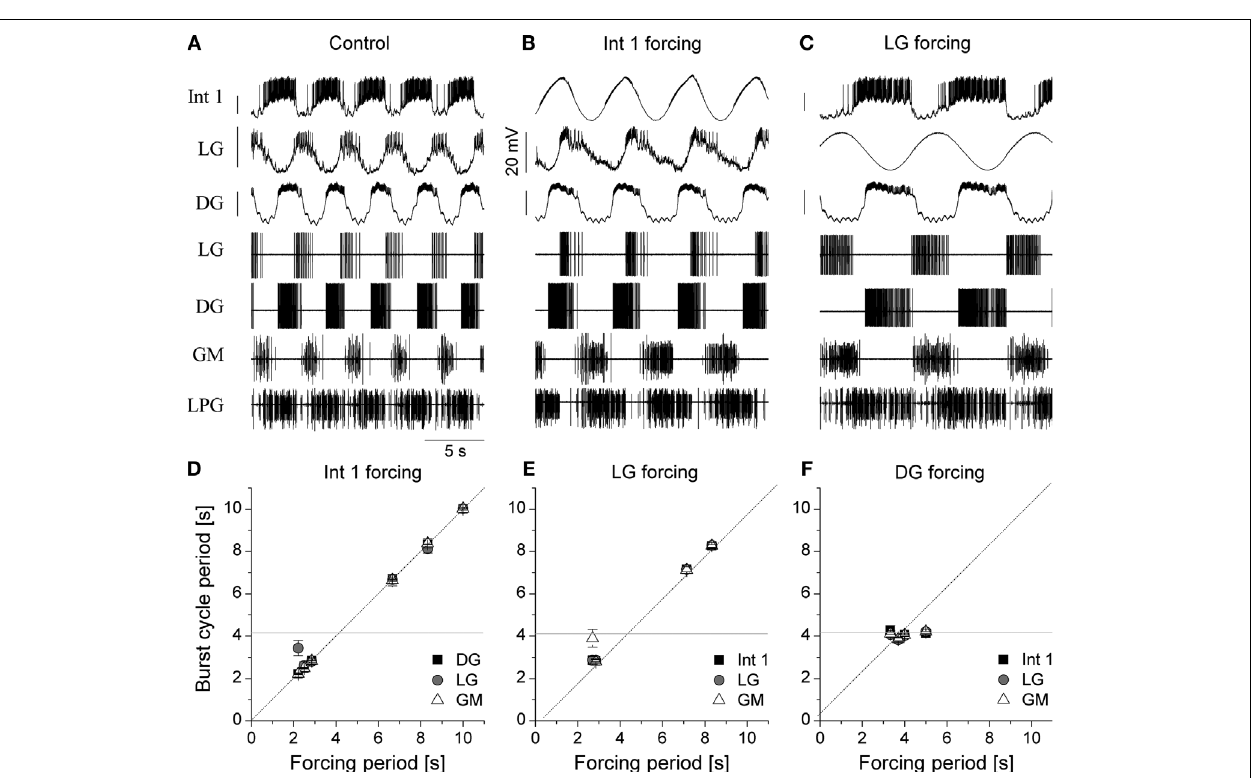
FIGURE 11 | Sinusoidal forcing of gastric neurons reveals a wide dynamical range of the network and shows the relative importance of circuit elements. The neurons were stimulated with a constant amplitude (3 nA) but variable frequency sinusoidal current and the synchronization of the follower cells was evaluated as a function of the input frequency. Top panels show the voltage waveforms of the neurons and extracellular traces ( (A) is without stimulation). In the lower panels we displayed the burst cycle period of